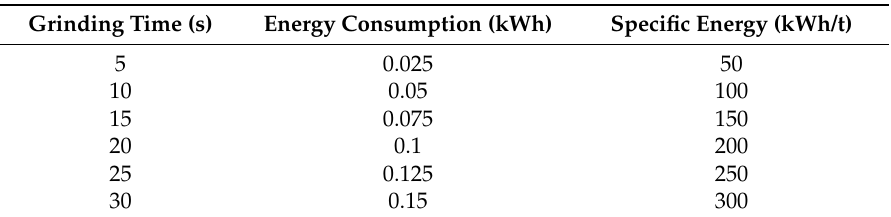
Table 3. Specific energy consumption in comparison with grinding